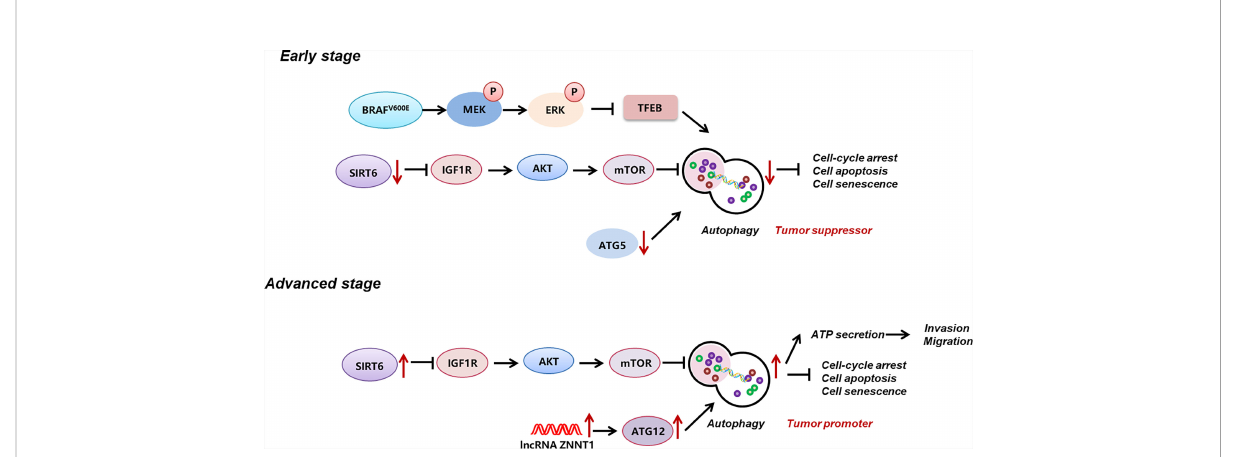
FIGURE 1 Reprogramming of autophagy in melanoma. During early stage, autophagy level in melanoma is signi fi cantly down-regulated, which is induced by MAPK activation-induced suppression of TFEB, the down-regulation of ATG5, and the down-regulation of SIRT6 and its-mediated IGF1R-AKT signaling. During advanced stage, autophagy level is prominent increased, which is related to the up-regulation of SIRT6 and its-mediated IGF1R-AKT signaling, and the up-regulation of lncRNA ZNNT1 and ATG12. Autophagy plays a bimodal role in melanoma progression, namely, acts as a tumor suppressor at early stage, whereas acts as a tumor promoter at advanced stage.